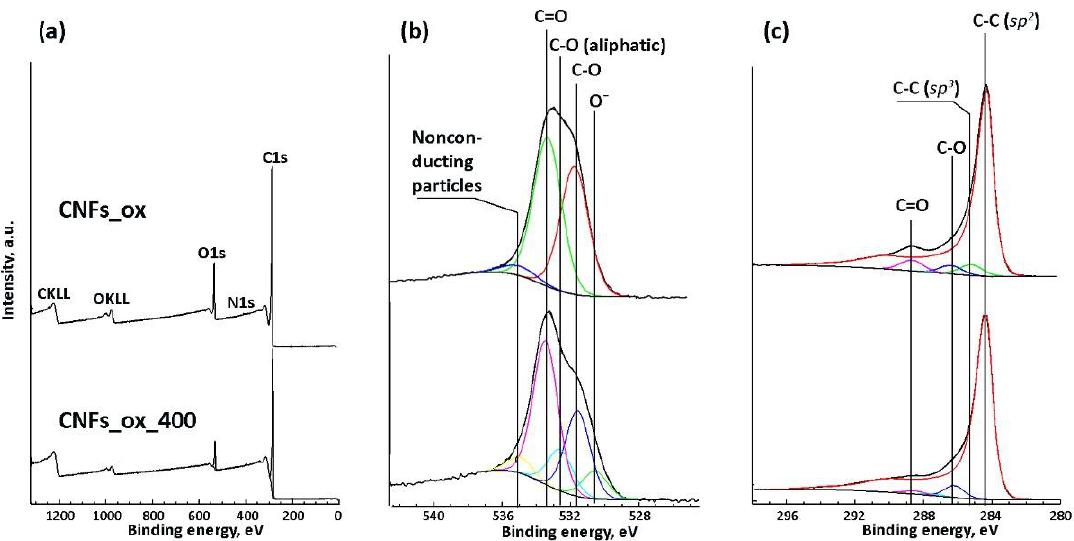
Figure 3. Survey ( a ), O1s ( b ), and C1s ( c ) XPS spectra of GNFs_ox (top) and GNFs_ox_400 (bot- tom).